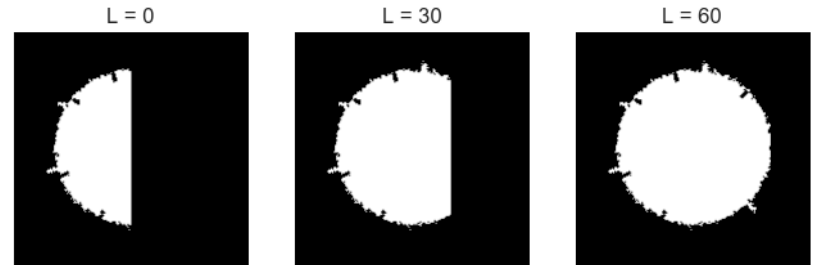
Figure 11. Illustration of the meaning of L parameter for Figure 6.